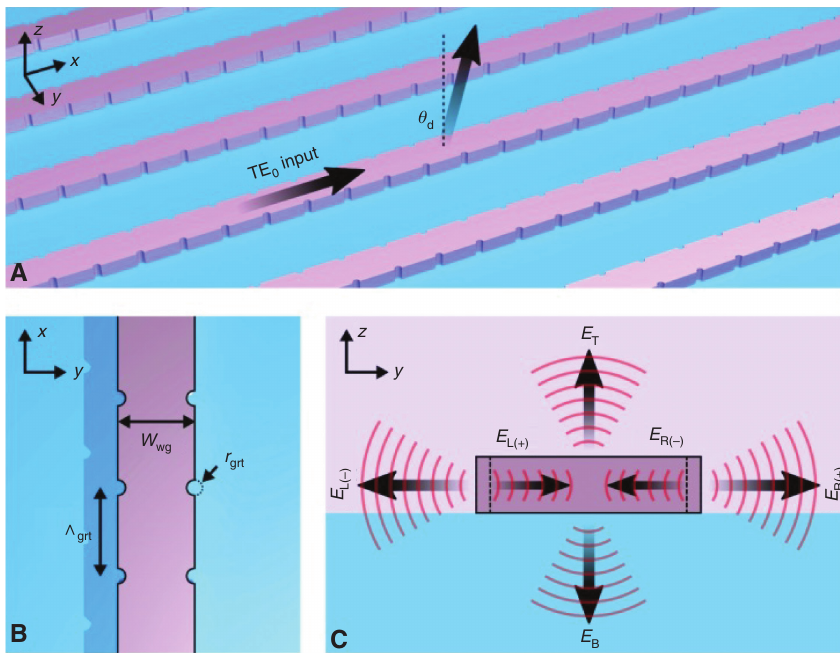
Figure 1: Working principle for BIC-based SWGA. (A) 3D view of SWGA. (B) Enlarged top view of SWGA with some key parameters labeled. (C) Schematics for the BIC effect in SWGA.